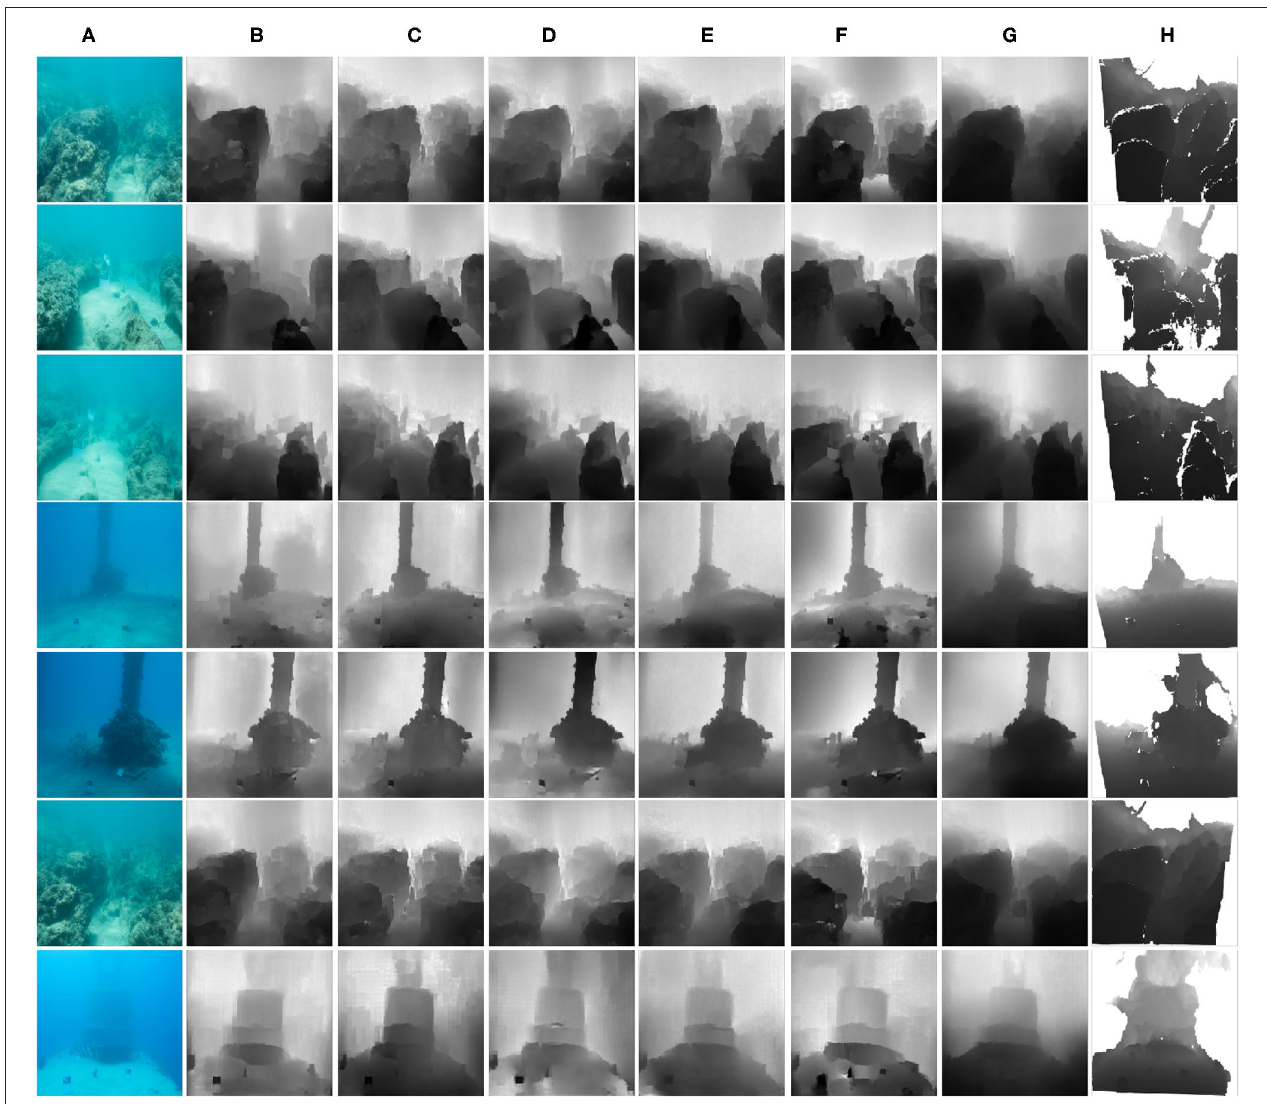
FIGURE 7 | Effectiveness evaluation of the L 1 , L 2 , L ssim , L msssim , and L depth . From left to right, respectively, (A) are real underwater images, (B–H) are the results of depth map estimation with L1 loss, L2 loss, L ssim , L msssim , L pan , L depth , and their corresponding ground truths.